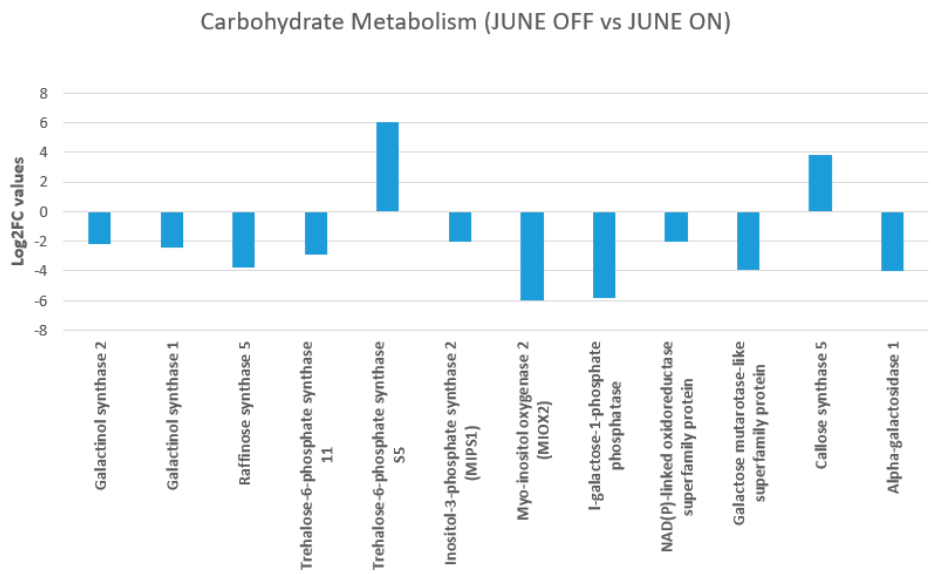
Figure 5. Figure shows carbohydrate metabolism and mobilization pathway in Pistachio among the June “OFF” vs June “ON” inflorescence bud comparison. The red circle represents the value of log2 fold change. The line indicates the e ff ects on carbohydrate levels driven by di ff erential expression of di ff erent CHO metabolism genes.